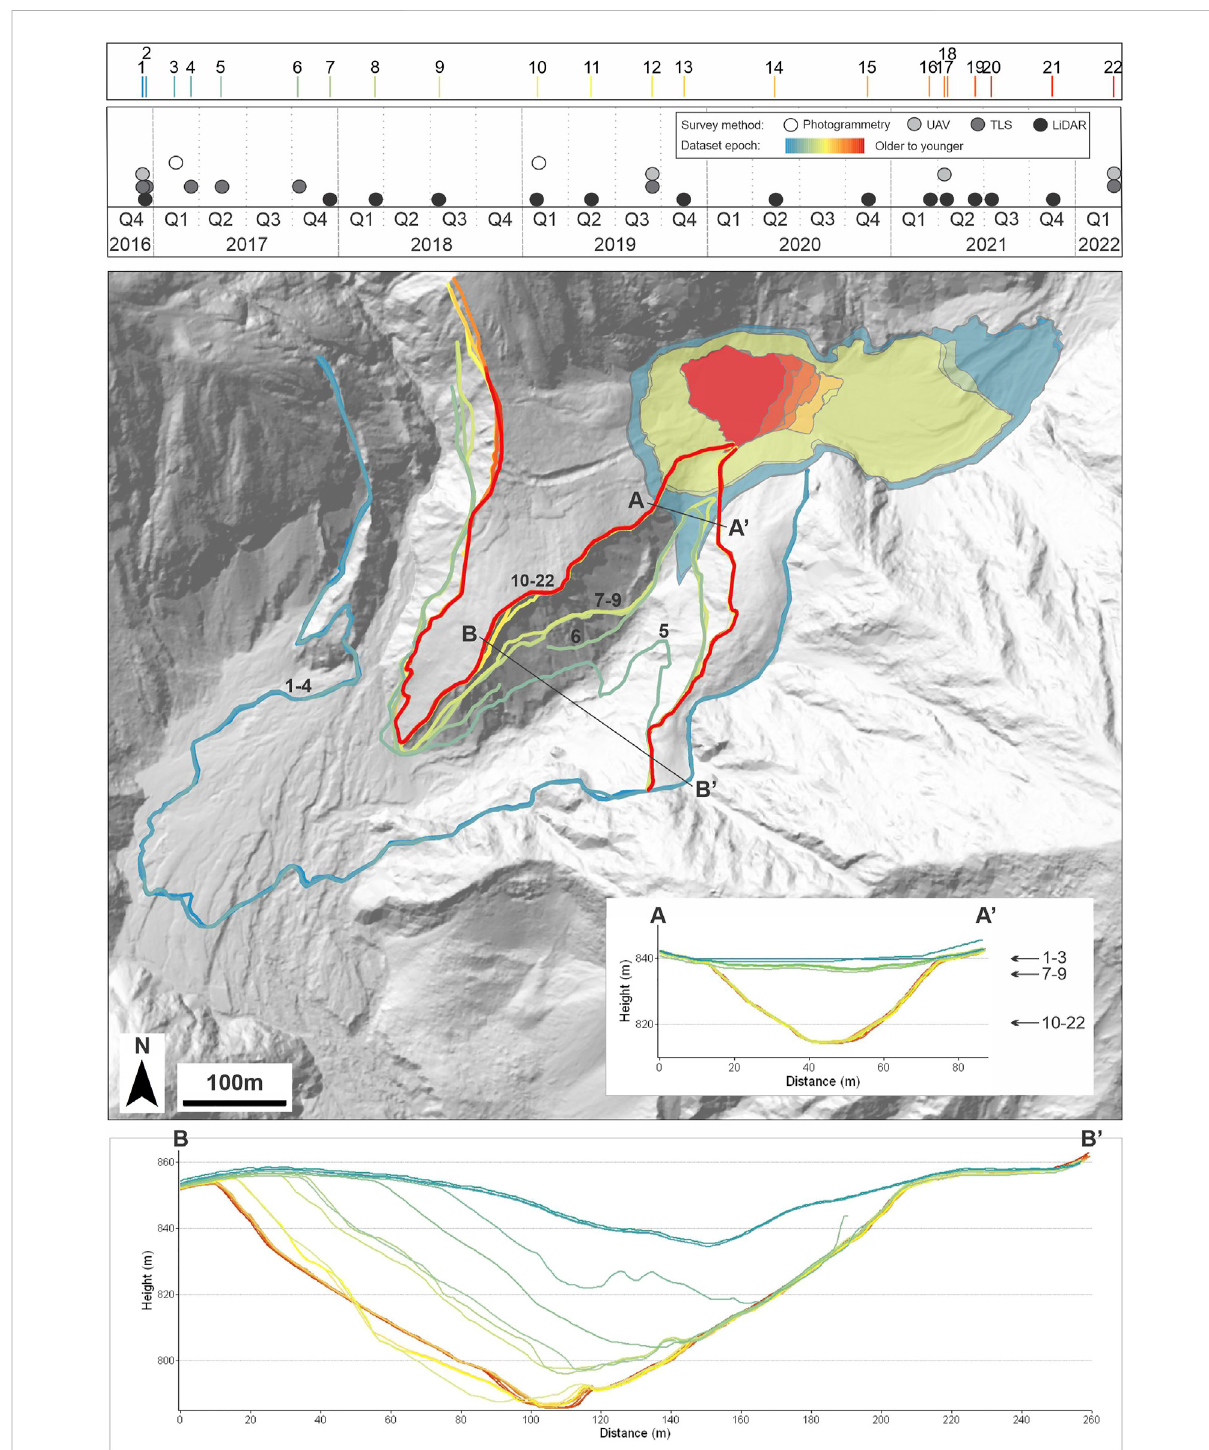
FIGURE 7 Evolution of the HRA dam deposit and lake from 2016 to 2022, mapped as lines and polygons corresponding to the dam and lake extents, respectively, overtime.ColourscorrespondtothedataepochsinTable1,andthewarmerthecolour,themorerecentthedataset.Epochsandtypes ofremotesensingdatausedinanalysingtheHRAarerepresentedinthetoppanel.Twopro fi lesalongtheSpillway,withlakelevelchangeindicatedin A-A ′ , are also shown. Numbers correspond to dataset